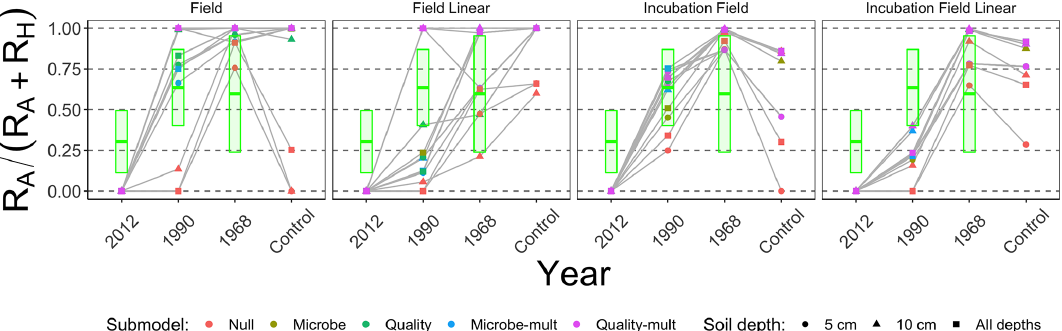
Figure 8. Median contribution of the proportion of autotrophic respiration ( p A = R A /R S ) from different parameter estimation approaches (field, field linear, incubation field, and incubation field linear), soil depth data used for parameter optimization (5cm, 10cm, or both depths together), and models (Null, Microbe, Quality, Microbe-mult, and Quality-mult). The crossbar plot shows predicted values of p A with twice the standard error from data reported in Fig. 1 in Ribeiro-Kumara et al.